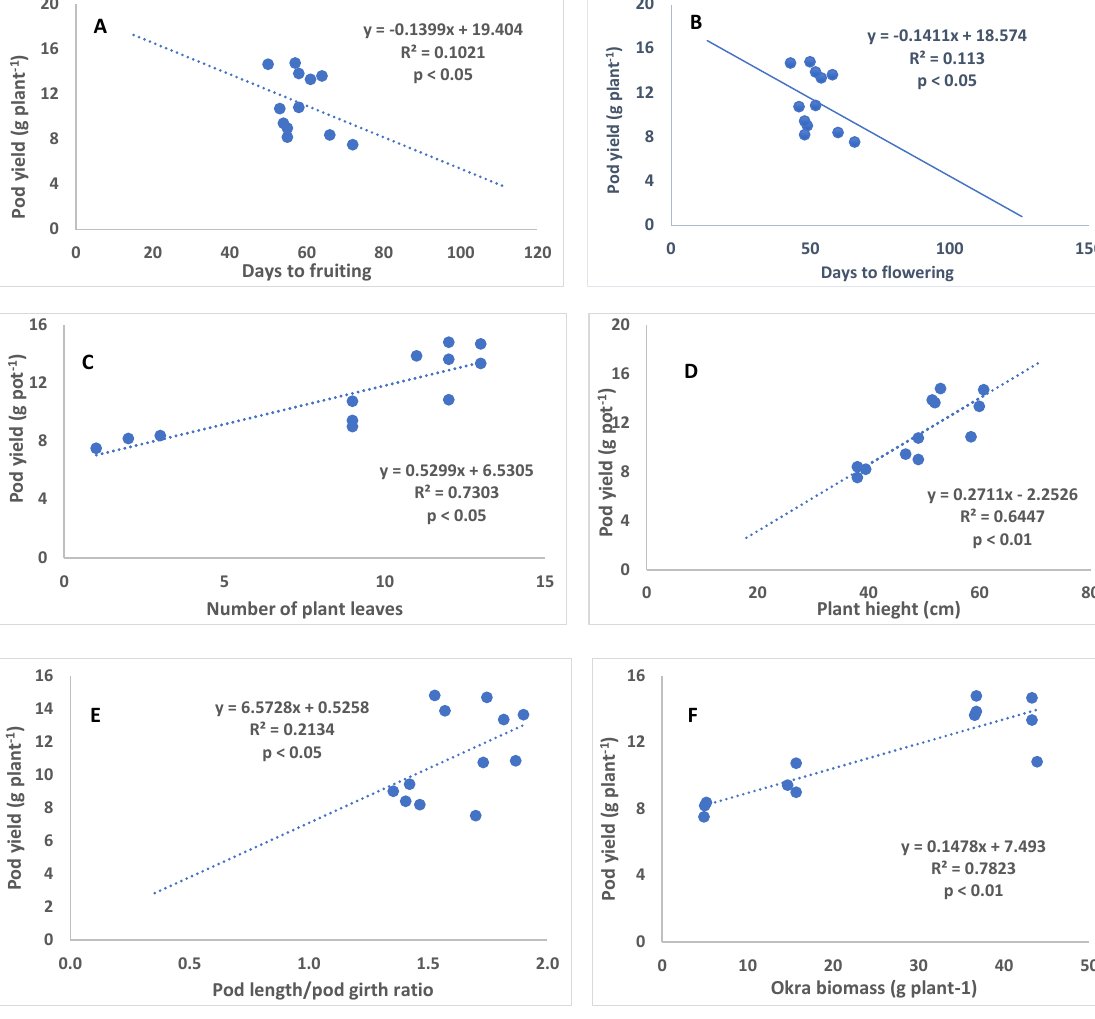
Fig. 2 Relationship between pod yield and days to fruiting (A), pod yield and days to flowering (B), pod yield and number of plant leaves (C), pod yield and plant height (D), pod yield and pod length/pod girth ratio (E), pod yield and biomass (F)